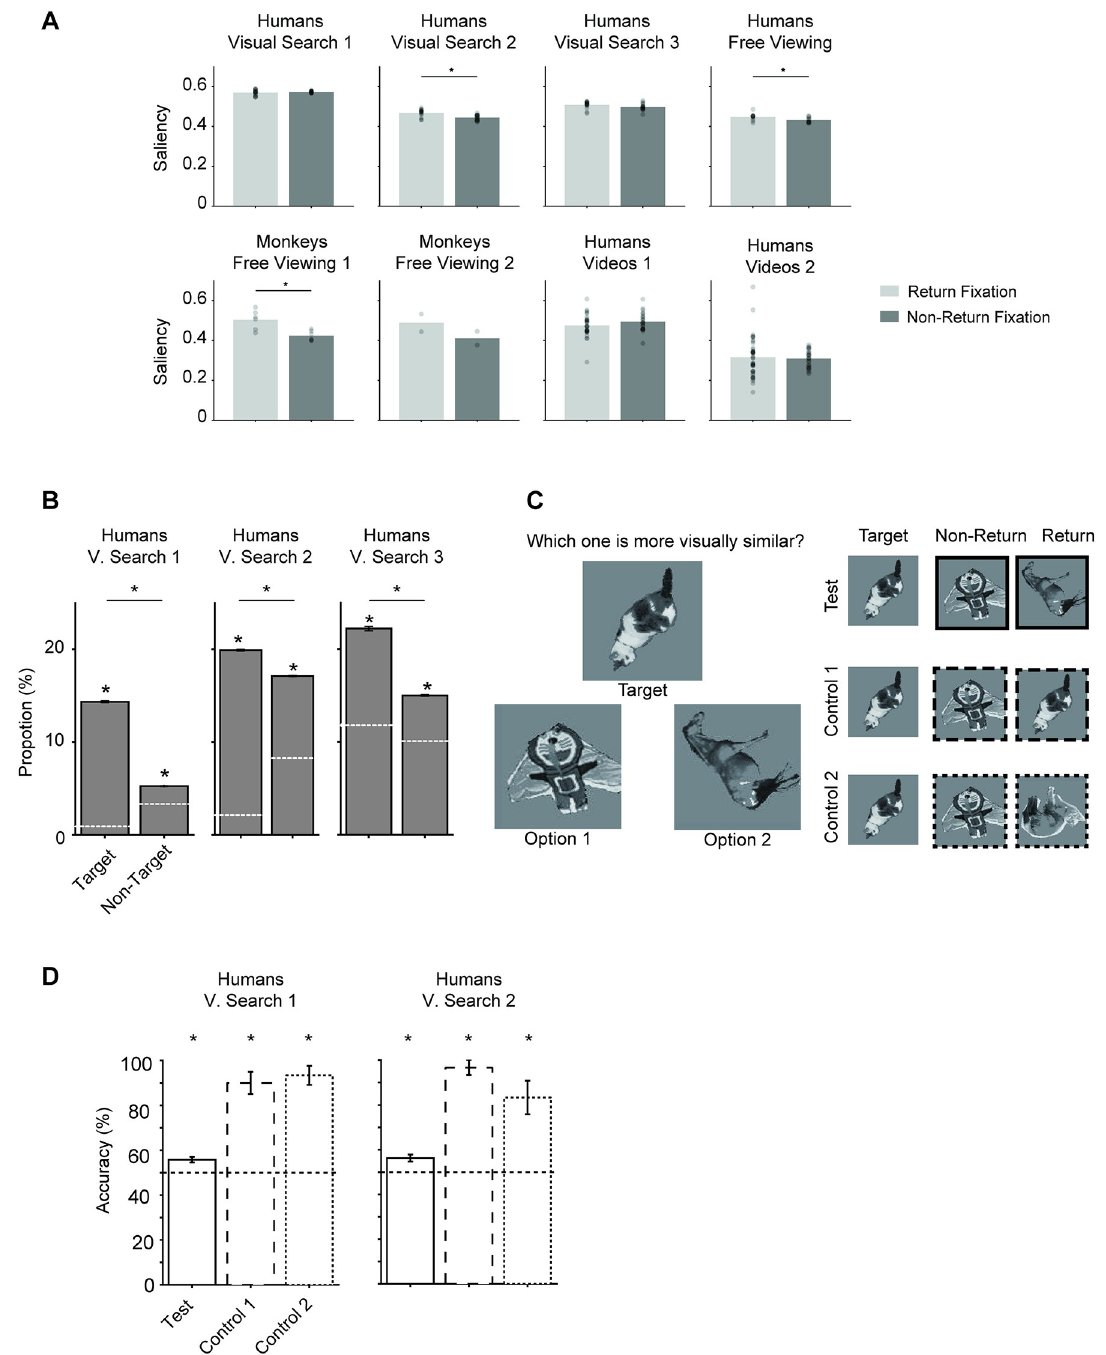
Fig 6. Return fixation locations depended on the image and task. ( A ) Return locations tend to show higher saliency. Each dot shows a different subject. � denotes p < 0.05, two-tailed t-test. To-be-revisited and return locations overlap by definition, saliency at to-be- revisited locations was similar to that at return locations.( B ) During visual search tasks, the proportion of return fixations was larger for target than non-target locations. Gray asterisks denote a statistically significant difference in the proportion of return fixations with respect to the chance levels. Black asterisks denote a statistically significant difference between target versus non-target locations. ( C ) Schematic of experiment to assess whether return fixations shared similarity to the target. In each trial, subjects were presented with an image (Target) and had to choose the more similar image between two alternatives. There were three conditions: (1) Test, where the two alternatives were return fixations versus non-return fixations, (2) Control 1, where the two alternatives were an identical copy of the target versus non-return fixations, and (3) Control 2, where the two alternatives were a different object from the same category as